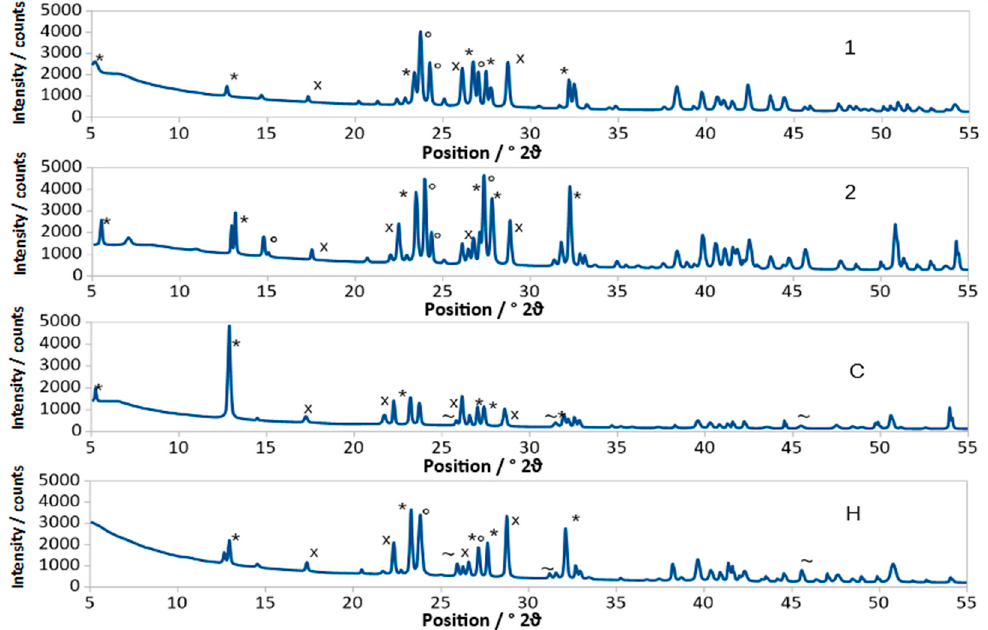
Figure 1. XRPD of samples 1, 2, C, H; Ba 5 Si 8 O 21 [36, PDF350766] (*), Ba 4 Si 6 O 16 [36, PDF831482] ( ◦ ) BaSi 2 O 5 [36, PDF260176] (x), NaCl [36, PDF882300] (~).